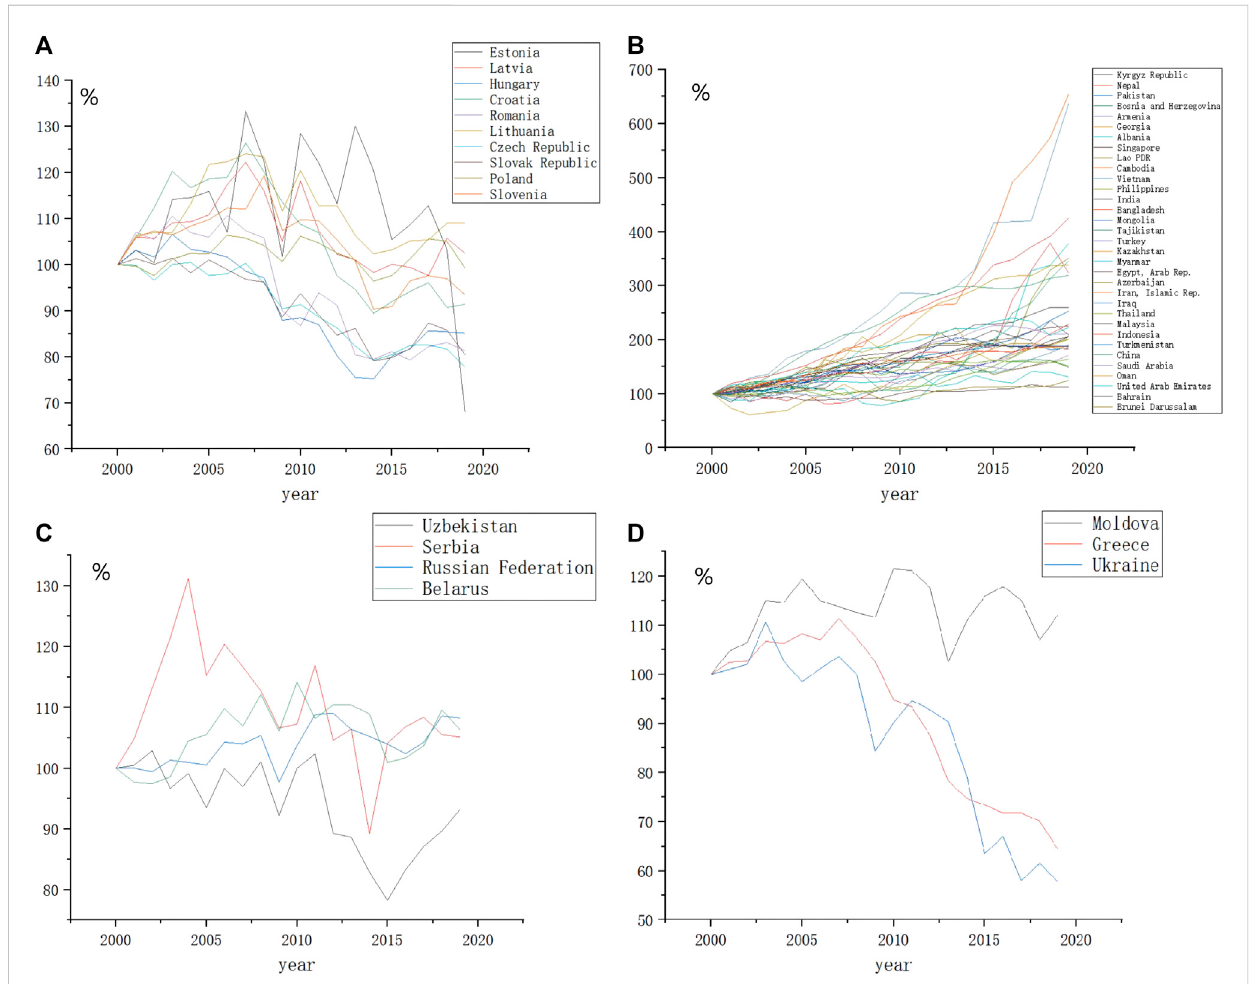
The trend of carbon emissions in countries along the Belt and Road. (A) Reached the peak; (B) Peak plateau period1 (the downward trend is not signi fi cant); (C) Peak plateau period2 (obvious recession); (D) Not reached the